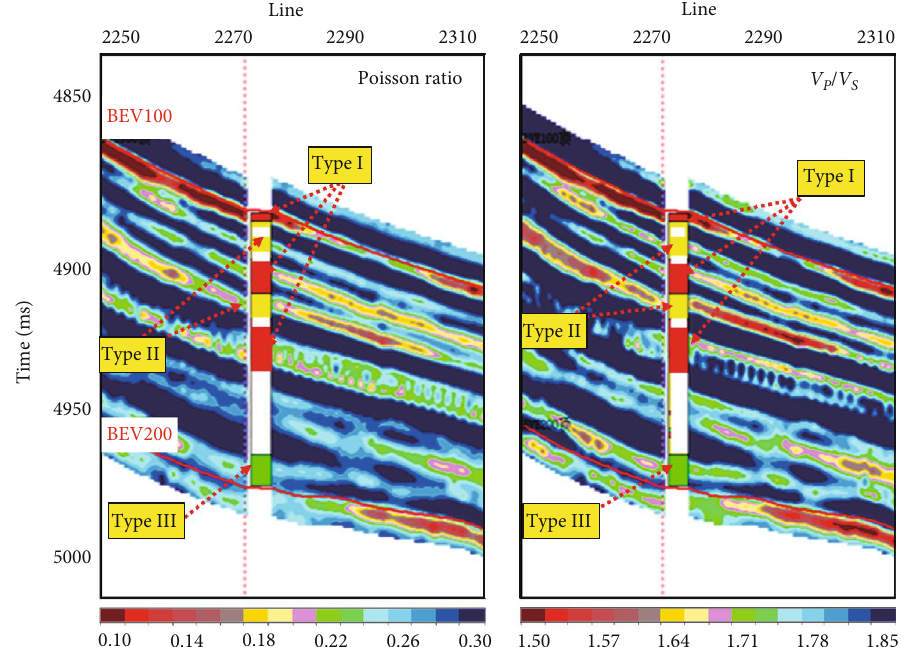
Figure 14: Comparison of the P-S wave velocity ratio and Poisson ratio inversion with the logging reservoir classi fi cation.